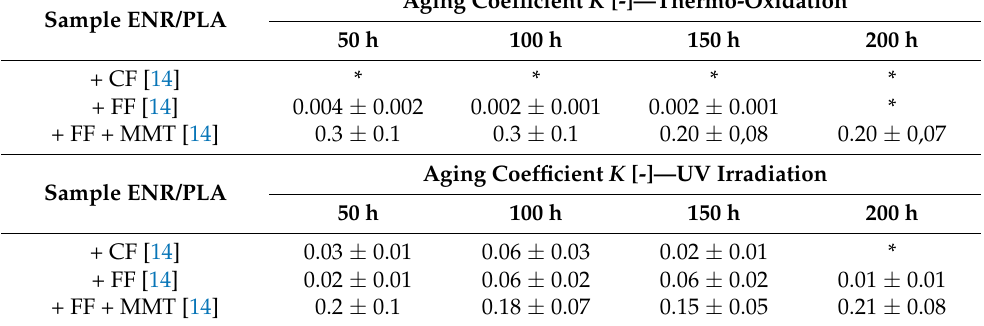
Figure 7. Aging coefficients attributed to the filled and unfilled ENR/PLA specimens at a certain aging time during thermo-oxidative ( a ) and UV ( b ) aging. Table 4. Comparison of aging coefficient values with the results presented in the previous part of the study [14]; CF—cellulose fibers, FF—flax fibers, MMT—montmorillonite. *—sample too brittle to be examined with the selected method; the measurement was